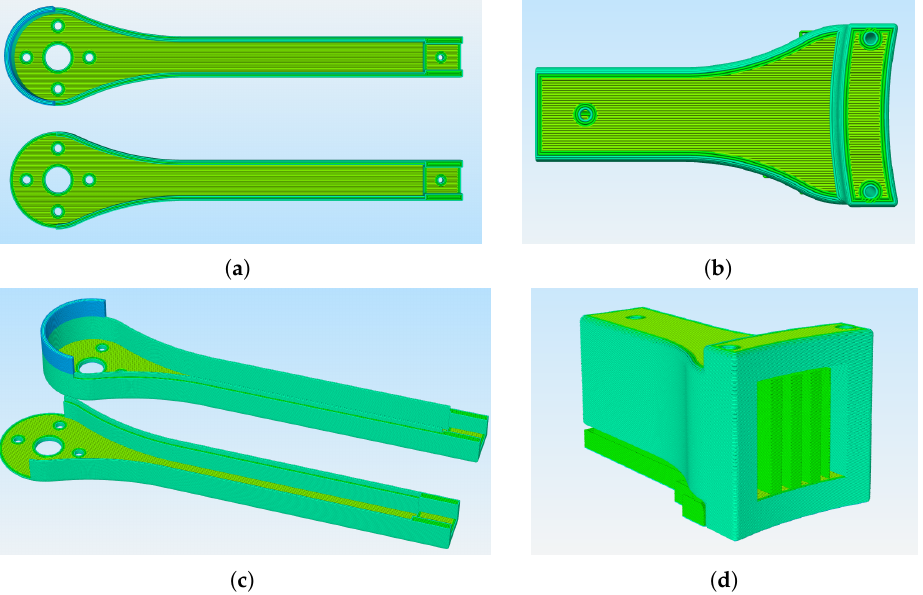
Figure 8. Components of the arm: preview of the 3D-printing strategy via FFF. ( a ) Arm elements, top view. ( b ) Support, top view. ( c ) Arm elements, side view. ( d ) Support, side